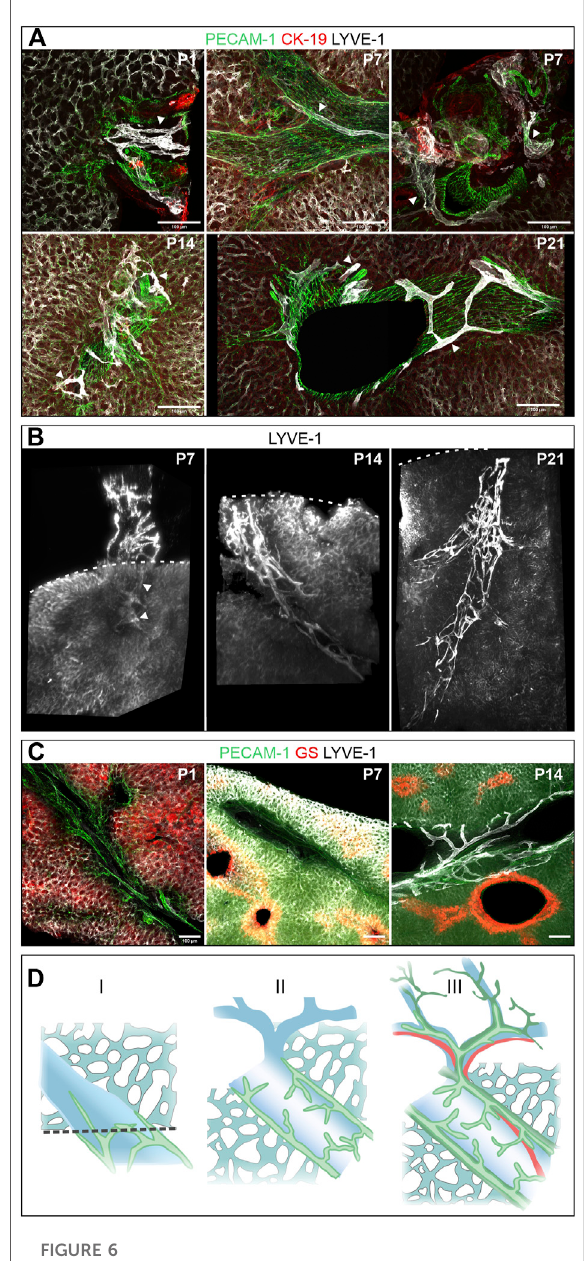
FIGURE 6 Postnatal development (the respective age is indicated in days after birth in the upper right corner of the panels). (A) : Vibratome sections (100 µm) of the right hepatic lobe of wildtype animals immunostained for PECAM-1, CK-19 and LYVE-1. Arrowheads denote lymphatic vessels, which were identi fi ed by high LYVE-1 expression, characteristic morphology and localization in portal tracts. Lymph vessels were restricted to large, super fi cial portal tracts until P7 (shown in longitudinal and cross- section),werefoundatincreasinglydeeperportaltractsatP14und fi nally displayed their typical branched morphology at P21. (B) : 3D reconstruction of LYVE-1 stained caudate lobes showed a stepwise increase in density and expansion within the hepatic parenchyma next to a portal tract (each portal tract approximately 60 – 70 µm diameter). The dashed line indicates the surface of the liver lobe, arrowheads intrahepatic LYVE-1 positive lymphatic ( Continued